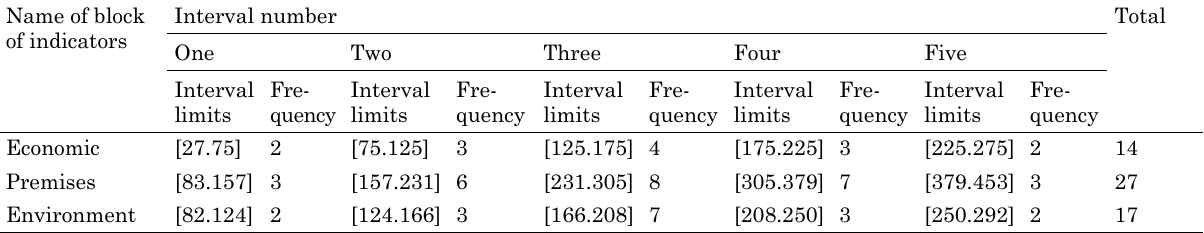
economic environment